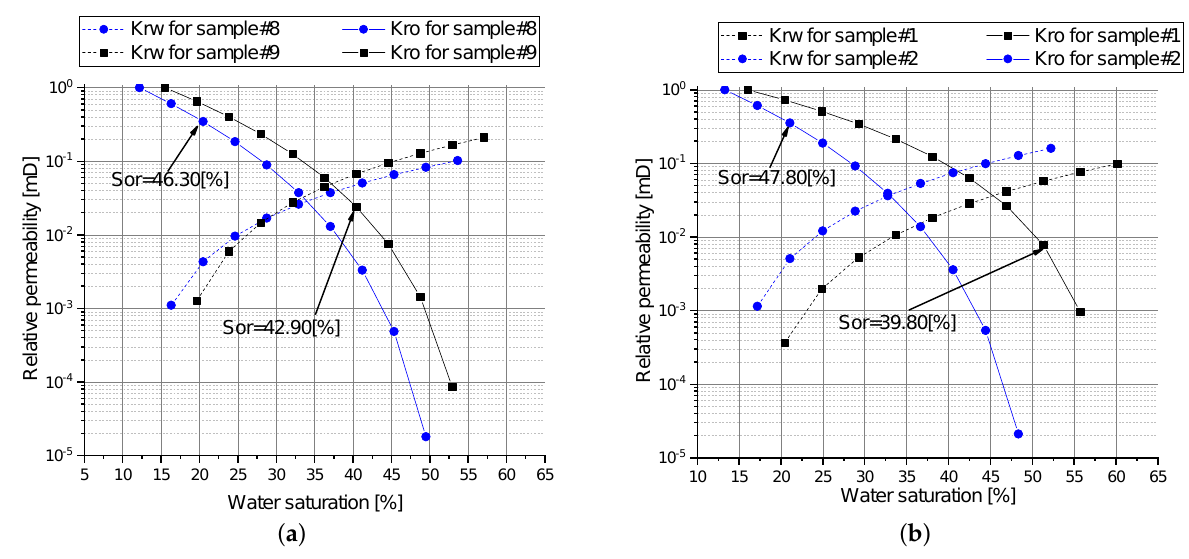
Figure 7. Water/oil relative permeability versus water saturation indicating the Sor permeability effect on the water/oil relative permeability ( a ) for samples 8, 9 and ( b ) for samples 1, 2. Table 1. Description of the experimental results including sample description, coast porosity,